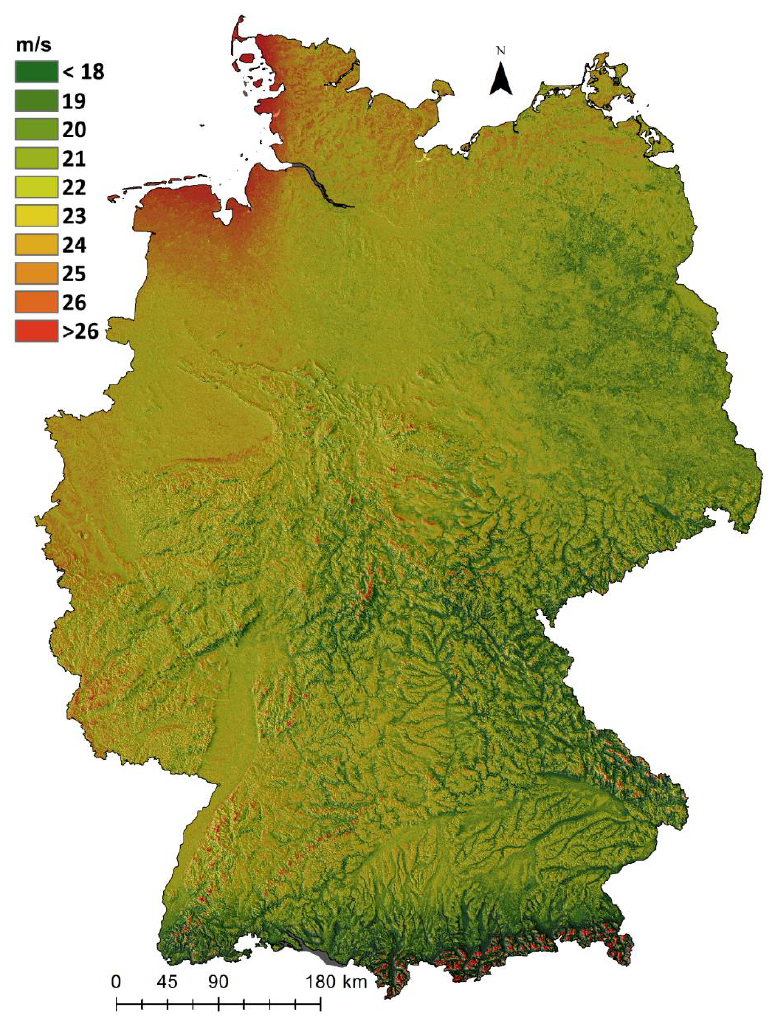
Figure 3. Median gust speed ( (cid:102) GS ) of all winter storms included in